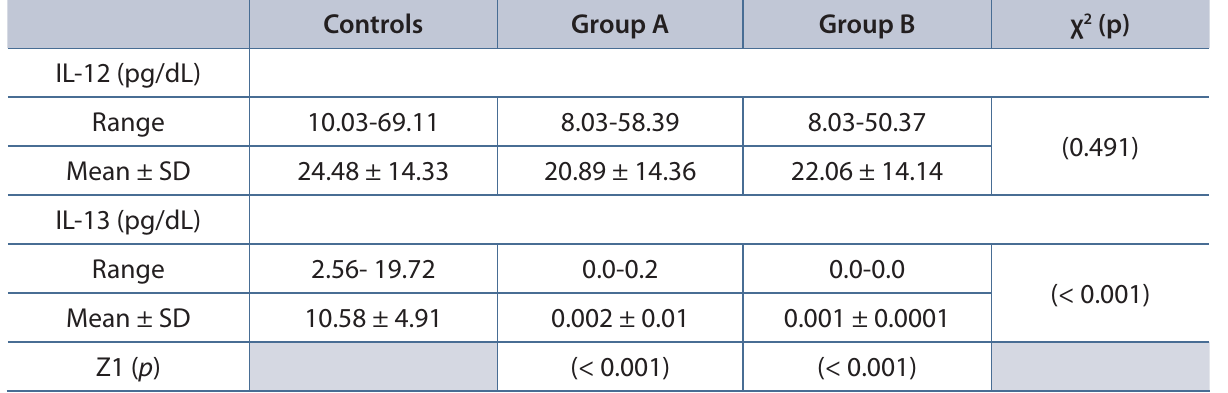
Table 3. IL-12 and IL-13 levels among the studied groups